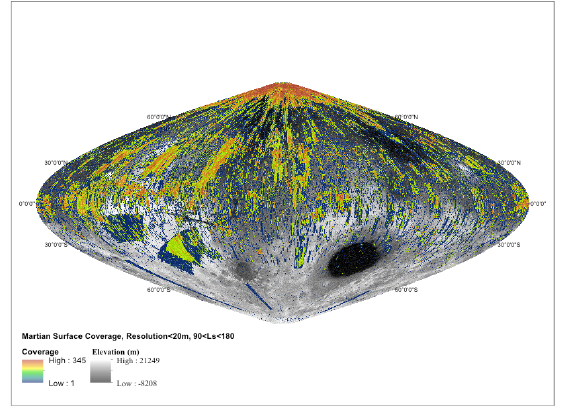
Figure 1: Martian surface coverage during north hemisphere summer ( 90 o <Ls<180 o ) from